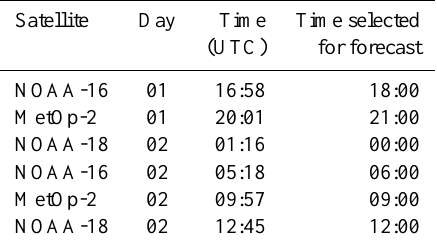
Table 2. Overpasses in November 2008 for the heavy precipitating event.